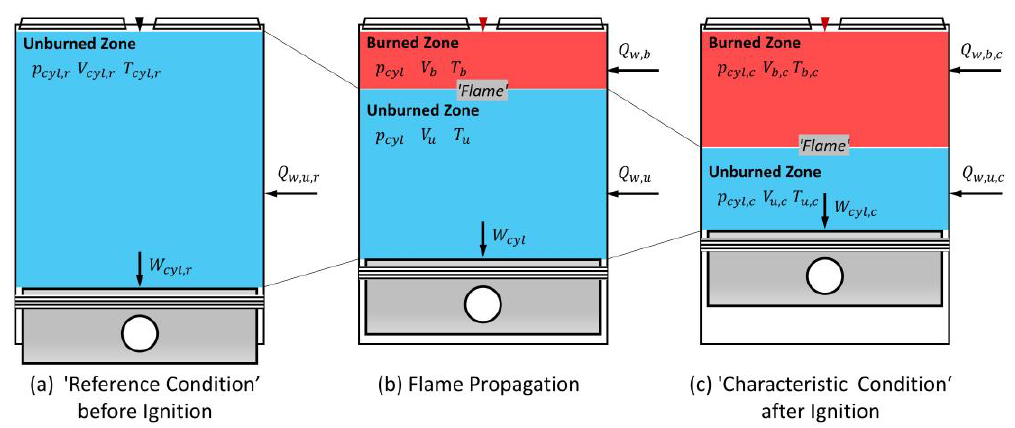
Figure 3. Characteristic thermodynamic process of a two-zone model.